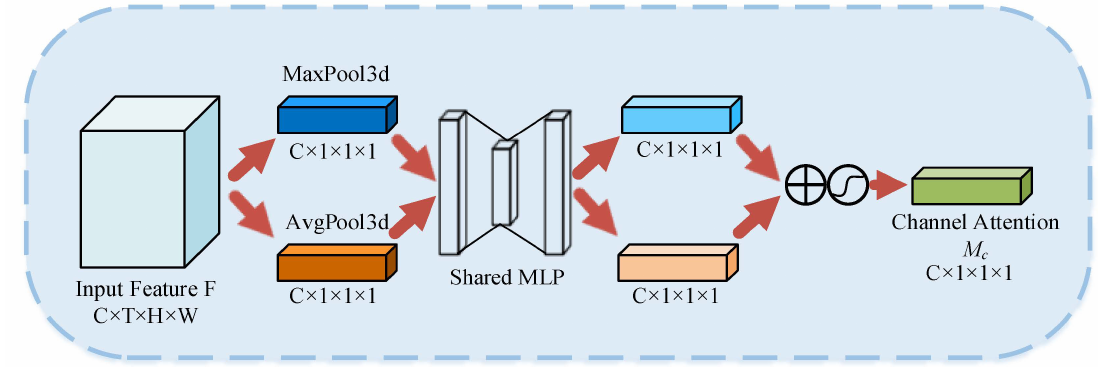
Figure 8. Channel Attention Module.